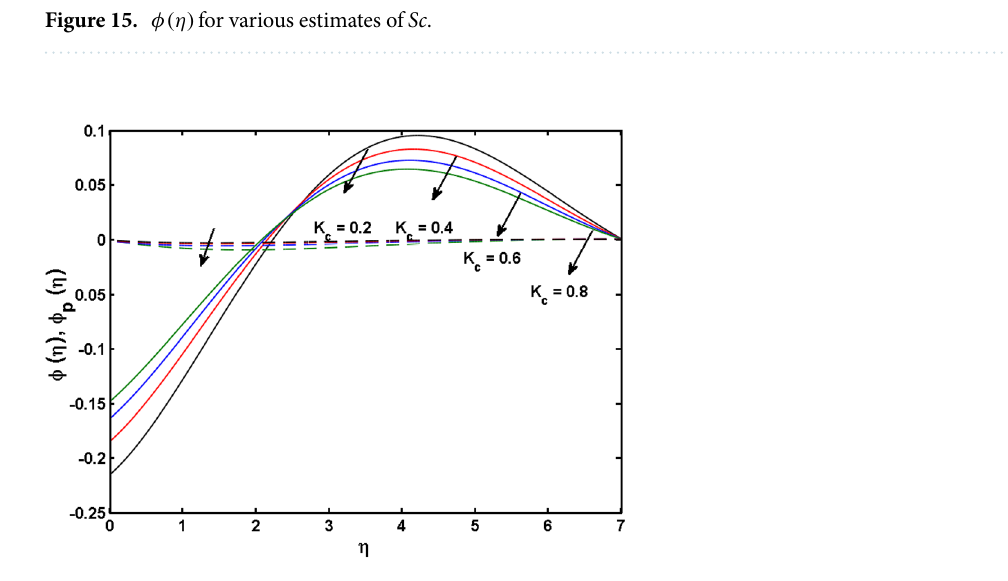
Figure 16. φ(η) for various estimates of K c